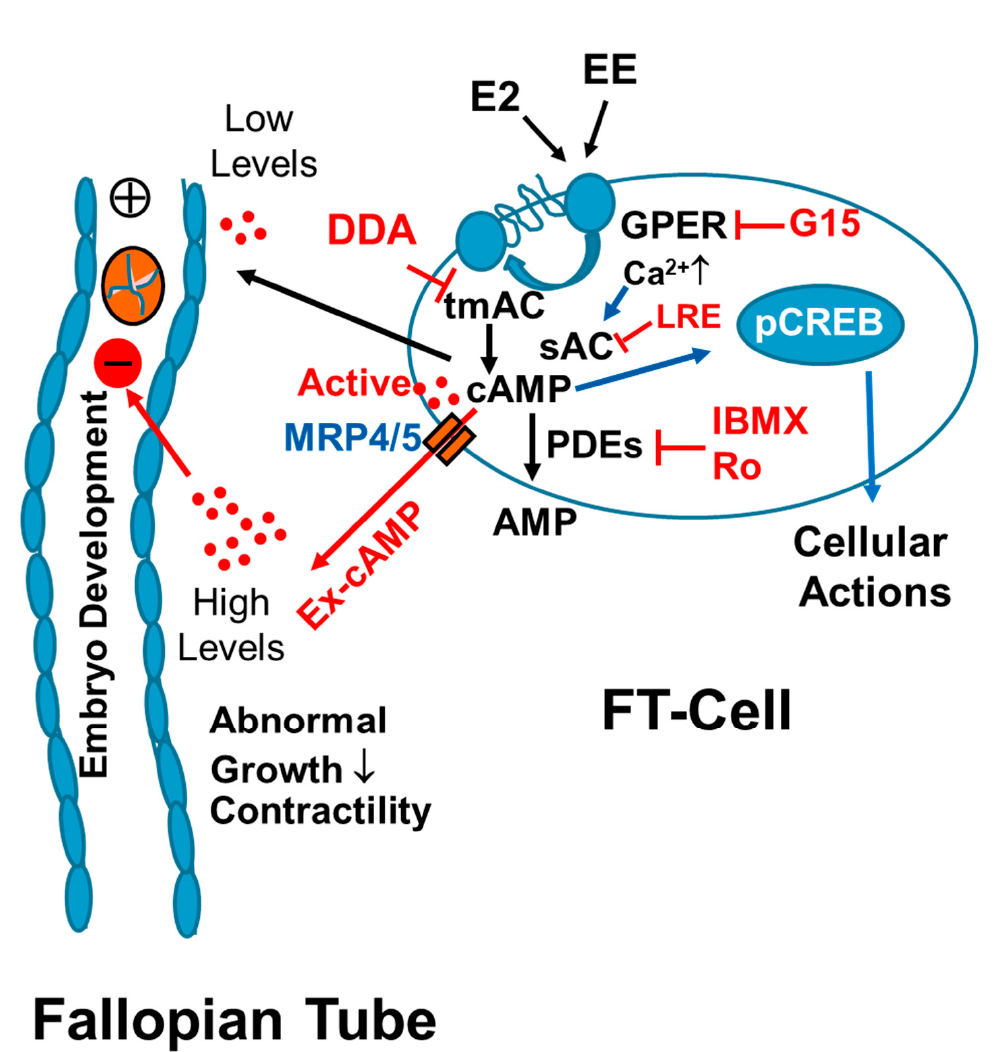
Figure 11. A schematic cartoon depicting the mechanism via which natural estrogens (E2) and environmental estrogens (EE) activate cyclic AMP (cAMP) generation by oviduct cells. Intracellular cAMP can mediate its cellular actions by phosphorylating CREB, and phosphodiesterases (PDEs) can metabolize/breakdown intracellular cAMP to AMP; moreover, cAMP is transported out of the cells by multidrug resistance-associated protein 4 and 5 (MRP4; MRP5). Using the G-protein coupled estrogen receptor (GPER) antagonist G15, transmembrane adenylyl cyclase (tmAC) inhibitor 2 (cid:48) 5 (cid:48) -dideoxyadenosine (DDA) and soluble AC (sAC) inhibitor LRE1 (LRE), we demonstrate that in FT cells E2 and EE induce cAMP production via GPER/AC signaling. Since cAMP is a potent muscle relaxant and growth inhibitor, we hypothesize that increased generation of intracellular cAMP and extracellular cAMP (ex-cAMP) in a non-cyclic fashion may induce deleterious actions on early embryo development and transport through FT. Importantly the effects of both E2 and EE may be significantly enhanced in presence of PDE inhibitors such as the anti-inflammatory drugs rolipram (Ro) and IBMX or food products containing caffeine. Changes in cAMP levels may play an important role in early embryo development and its